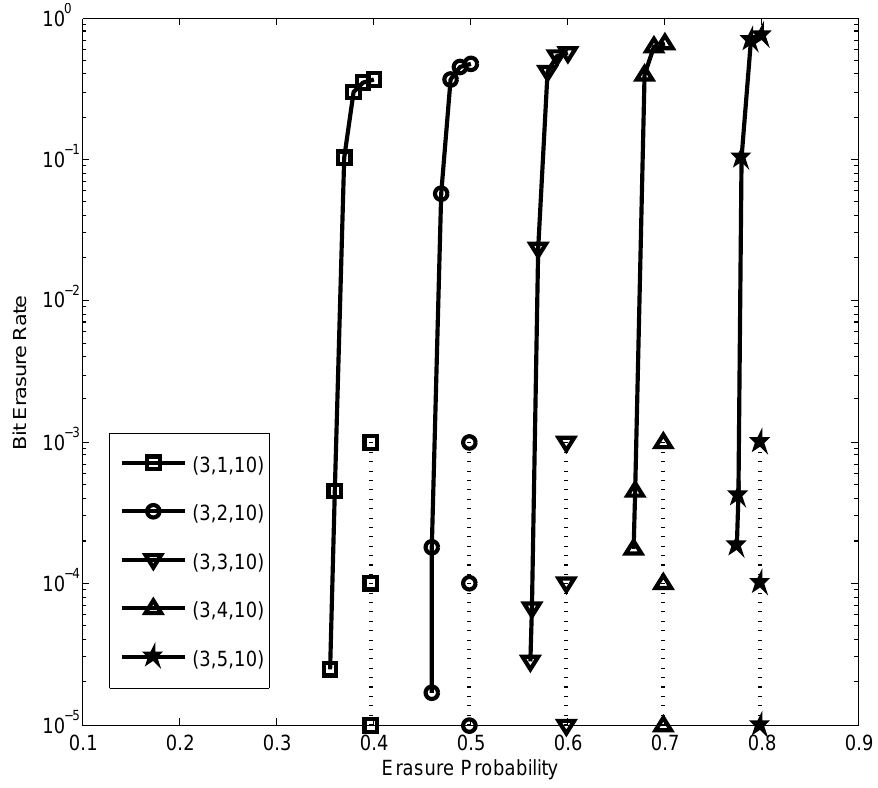
Figure 4. Bit erasure rates of the multi-edge-type (MET) spatially-coupled (SC)-LDPC codes over BECs. The solid curves show the simulation results, and the dotted vertical lines indicate the BP thresholds from density